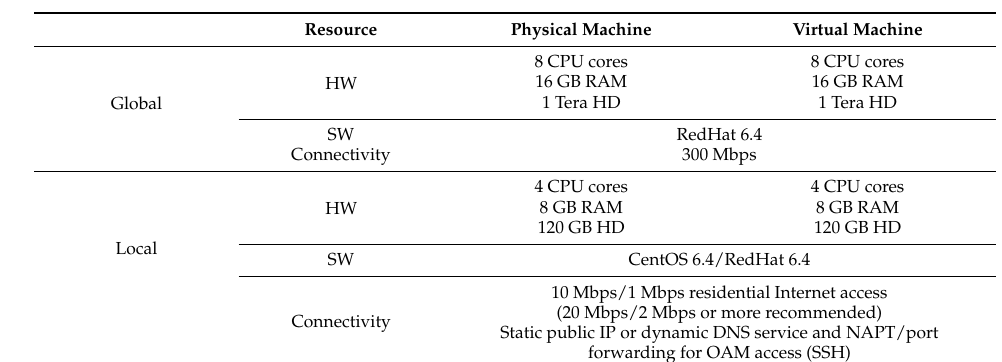
Figure 4. Diagnosis architecture. Table 2. Resources requirement.